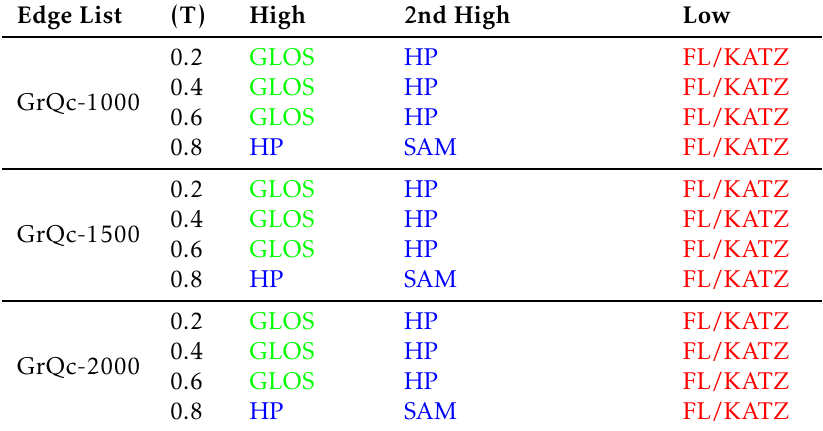
Table 5. The table presents the results of accuracy on GrQc Dataset. Where, (T) represents the threshold, High represents the similarity measures obtaining highest accuracy, 2nd High corresponds to the similarity measures obtained second highest accuracy and low represents the similarity measures obtained lowest accuracy. The red color shows the Global approaches, the blue color shows the Local approaches and the green color shows the Hybrid